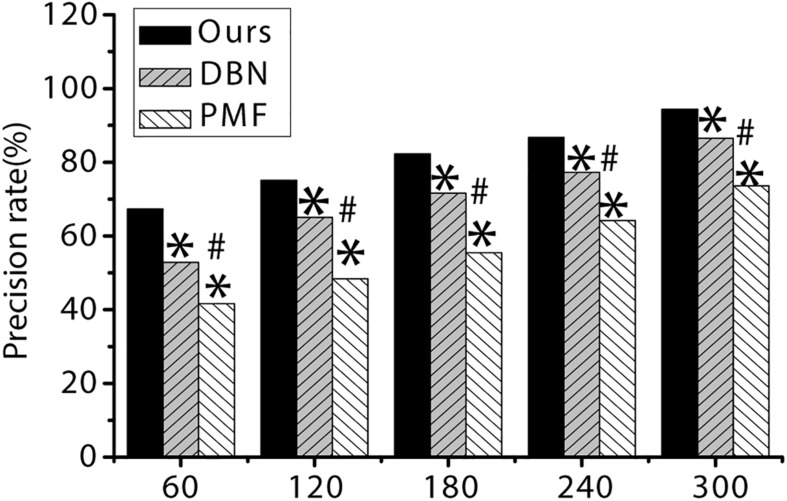
The accuracy of the three algorithms under different item quantity. ∗ indicates that the difference is statistically significant compared with the algorithm proposed in the study (p < 0.05). # indicates that the difference is statistically significant compared with DBN algorithm (p < 0.05).